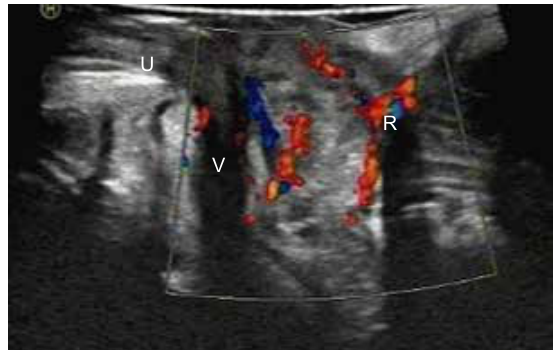
Figure 4 The transperineal image illustrateed irregular thickening of the vaginal wall in a 7-year-old girl. U, urehra; R, rectum; V, vaginal wall.